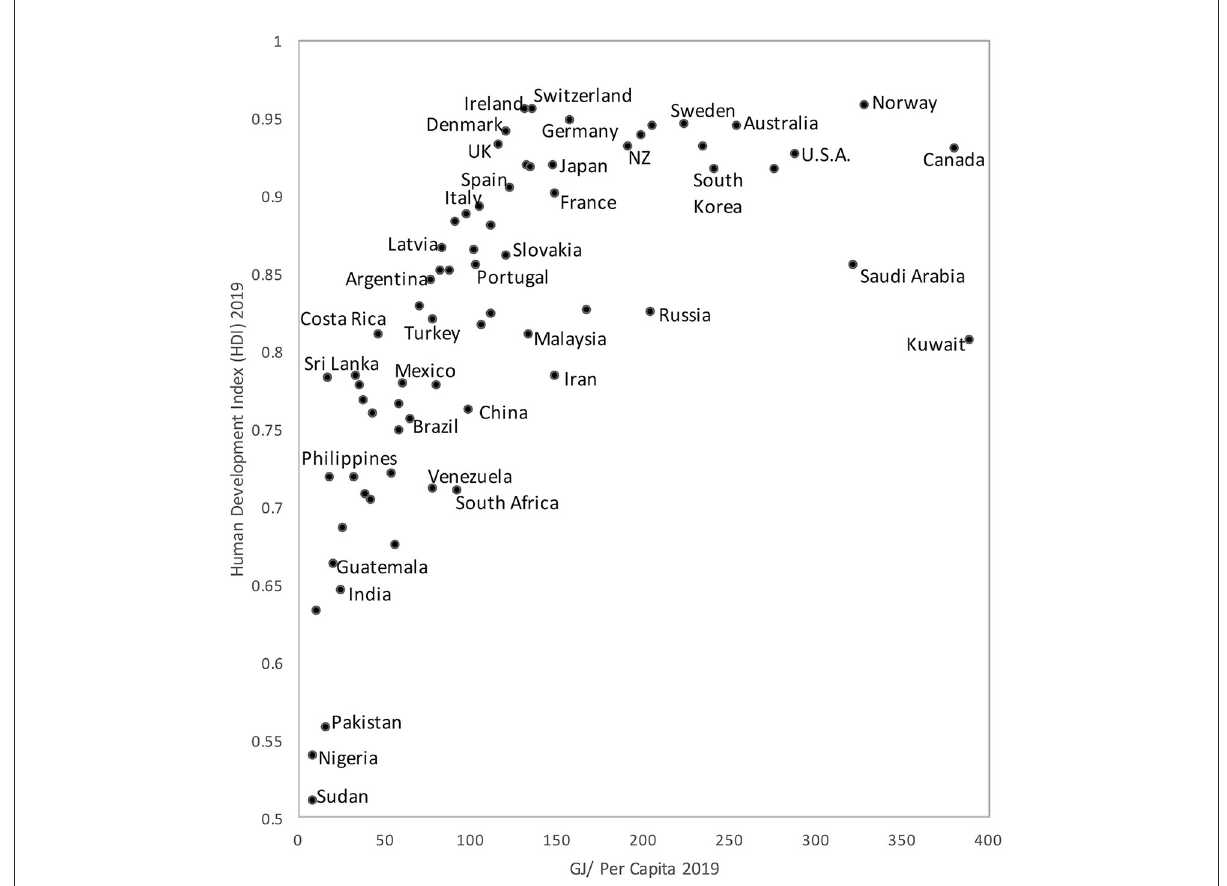
FIGURE1 Human Development Index as related to energy use (gigajoules) per capita. Authors. Data sources: UNDP HDI and BP Statistical Review of World